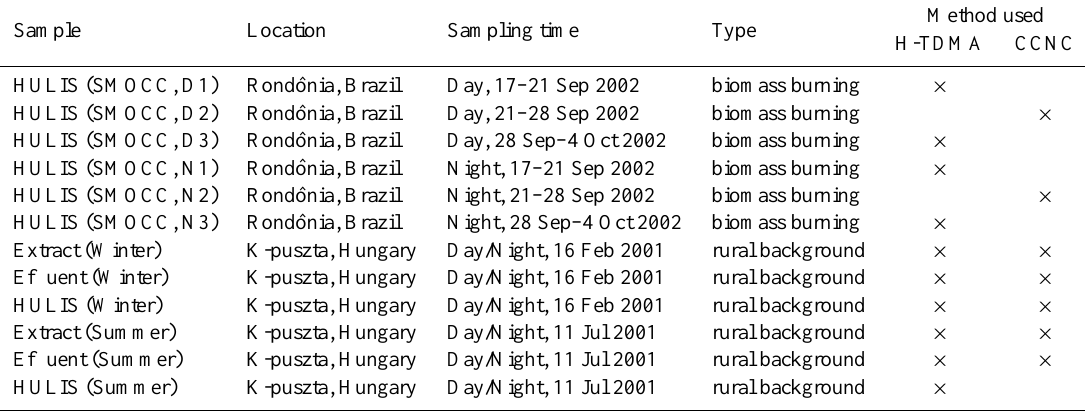
Table 1. Origin of aerosol samples analysed with the H-TDMA and the CCNC techniques.